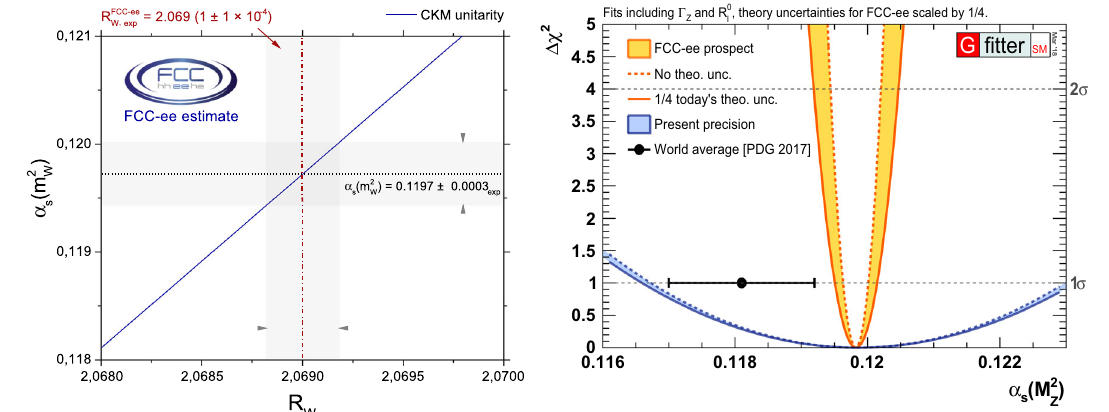
Fig. 5.1 Left: expected α s extraction from the hadronic/leptonic W decay ratio (R W ) at the FCC-ee (the diagonal blue line assumes CKM matrix unitarity) [45]. Right: precision on α s derived from the elec-